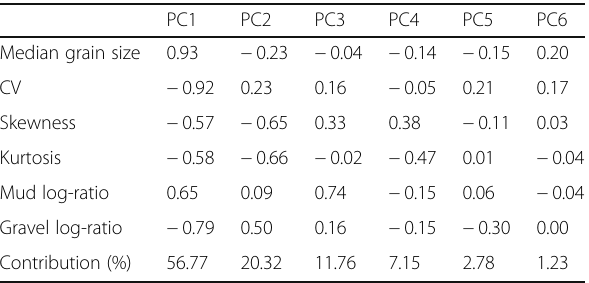
Table 1 Result of principle component analysis (PCA) for the samples from the Kushida River Delta. Factor loadings and contribution values are shown PC1 PC2 PC3